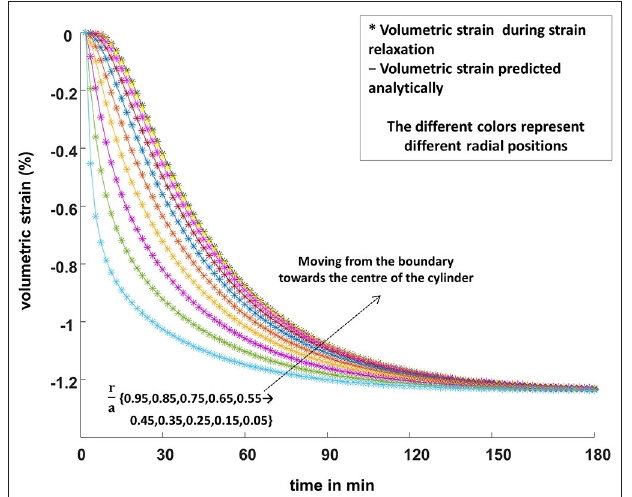
FIGURE 7 | The FEM predictions of the spatially varying volumetric strain (“*” symbols) inside a cylindrical poroelastic sample subjected to a constant compressive axial force, undergoing strain relaxation, are plotted along with the analytical predictions (Equation 7; solid lines). The volumetric strain decreases more rapidly for large values of the radial position r, where the pore fluid first leaves the sample, than for positions closer to the center of the cylinder, where the fluid contained in the pores is the last to leave its original location. The different colors represent different radial positions, r/a : cyan 0.95, lime 0.85, purple 0.75, yellow 0.65, orange 0.55, blue 0.45, brown 0.35, magenta 0.25, yellow 0.15, and olive 0.05.